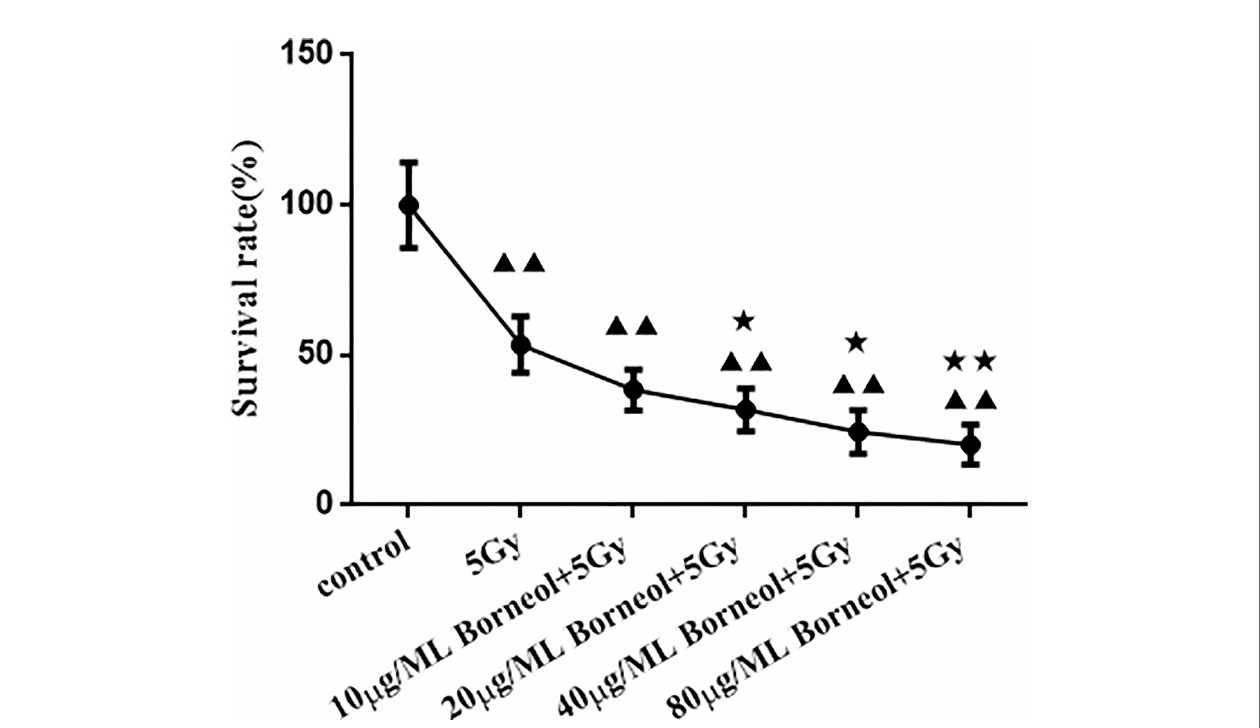
FIGURE 4 | Effects of different concentrations of borneol on the growth of human glioma primary cultured cells under the radiation dose of 5Gy ( (cid:1) x ± S, n =3). Compared with control group, ▲▲ P< 0.01; Compared with the radiation 5Gy group, ★ P<0.05, ★★ P< 0.01.